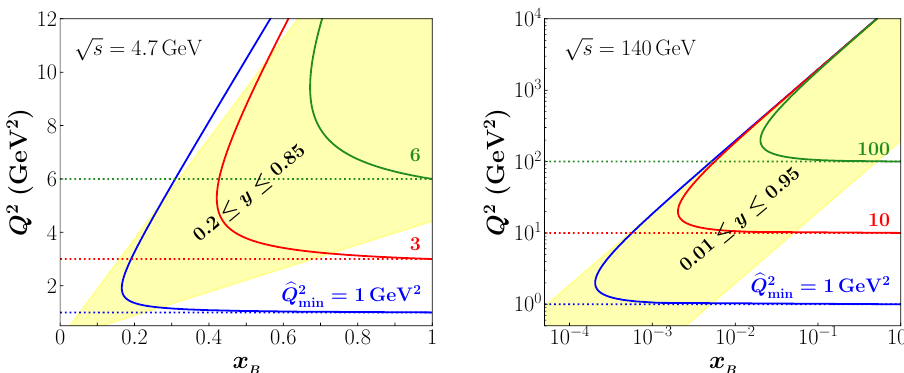
Figure 9 . Available phase-space for lepton-nucleon DIS with collision-induced QED radiative √ √ contributions at Jefferson Lab ( s = 4 . 7 GeV) (left) and EIC ( s = 140 GeV) (right) kinematics. The colored lines denote regions of fixed b Q 2 and the diagonal yellow bands represent typical min ranges of y at those